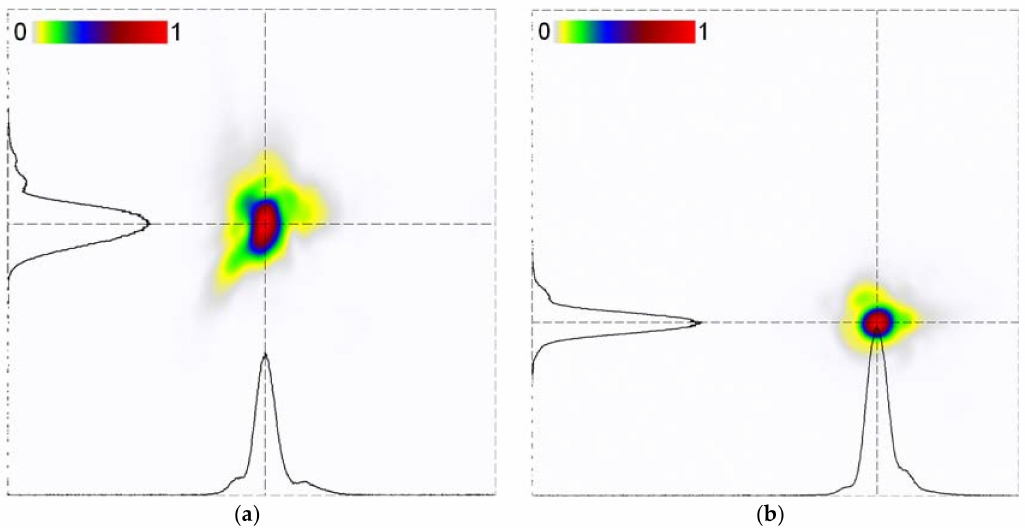
Figure 2. Focal spot shapes corresponding to ( a ) the largest and ( b ) smallest spots used in the experiments. The effective spot radii are 10.1 and 6.9 µ m, while the Full Width at Half Maximum (FWHM) sizes are 9.4 µ m × 17.6 µ m and 10.0 µ m × 9.4 µ m, respectively. The full frame size is 200 µ m, and the laser polarization is horizontal for both ( a , b